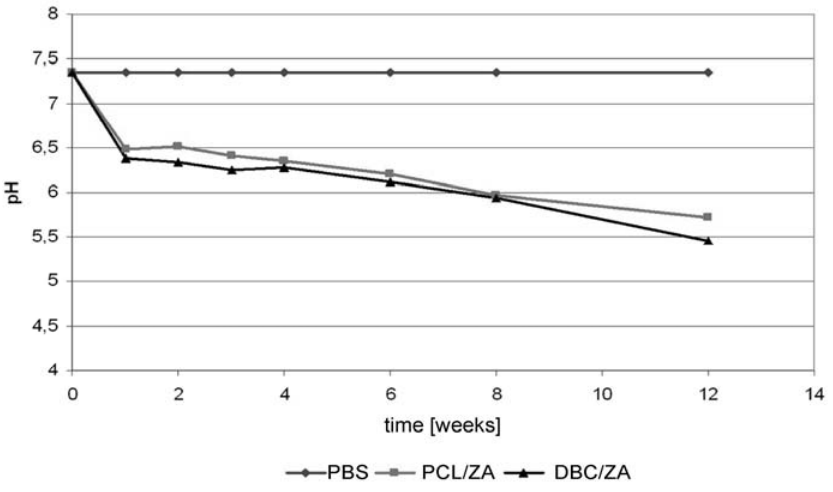
Figure 7. Change in pH of the medium for PCL/ZA and DBC/ZA composites in